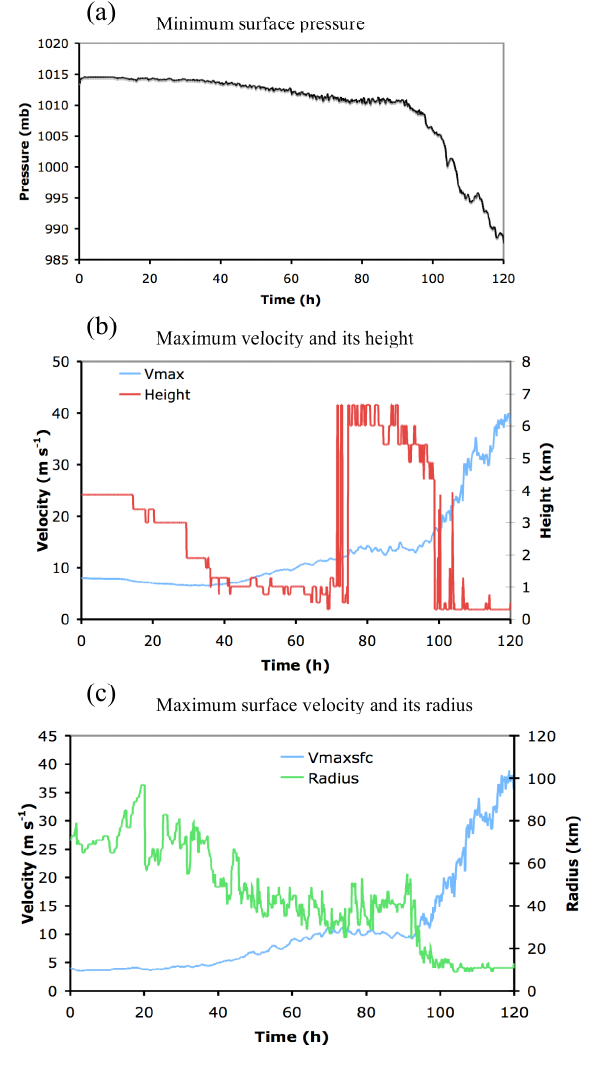
Figure 8. As in Figure 2, for Experiment 5. Fig. 8. As in Fig. 2, for Experiment